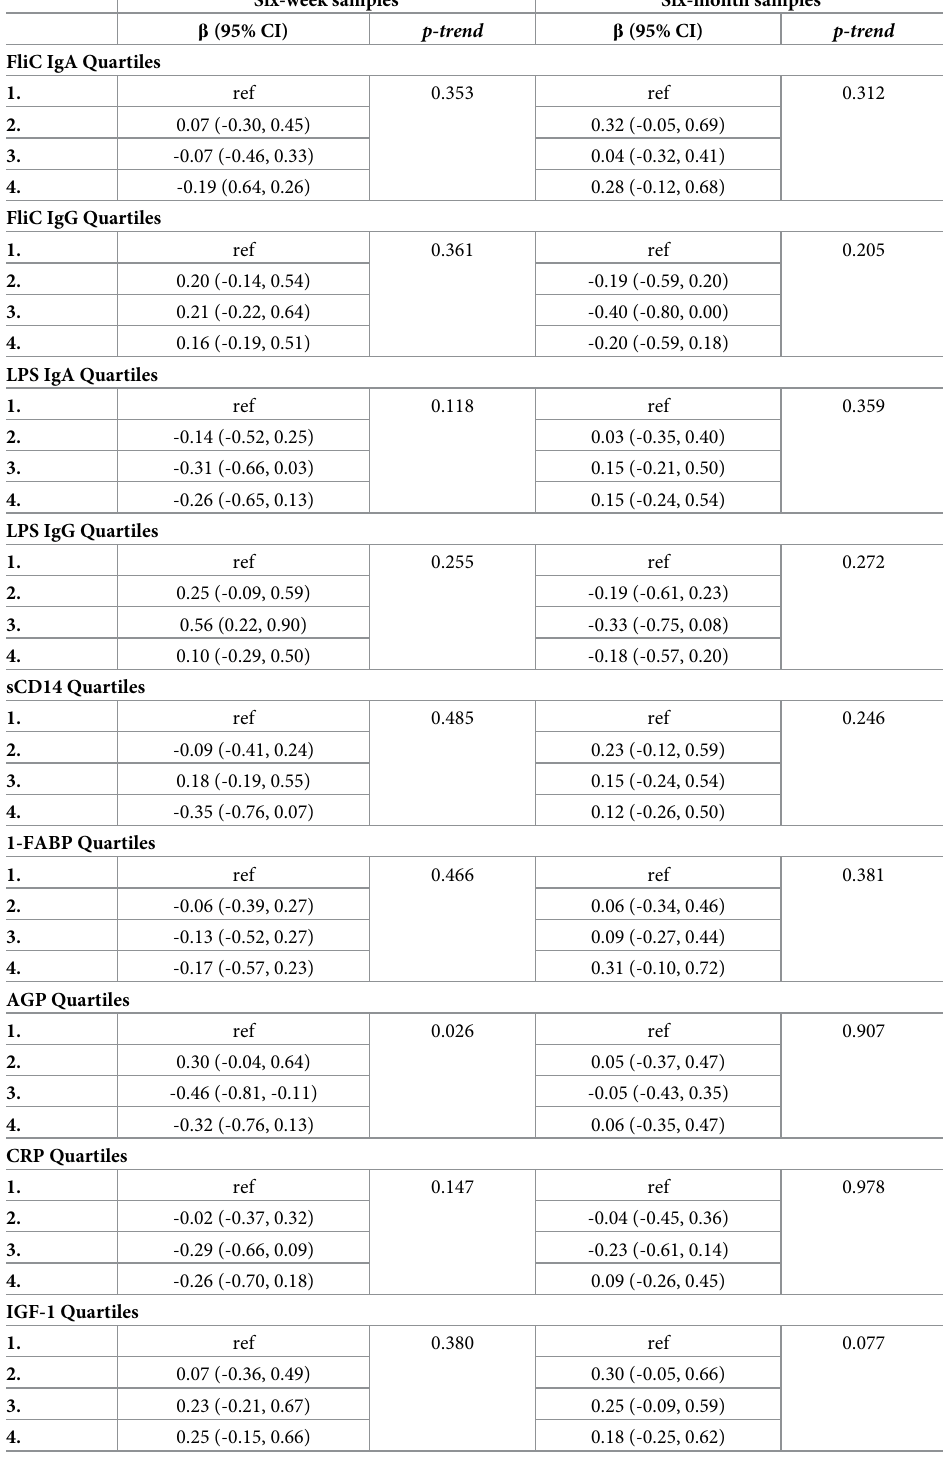
Table 4. Associations between biomarker concentrations (quartiles) at 6 weeks and 6 months of age and overall CREDI z-score at 12 months of age 1